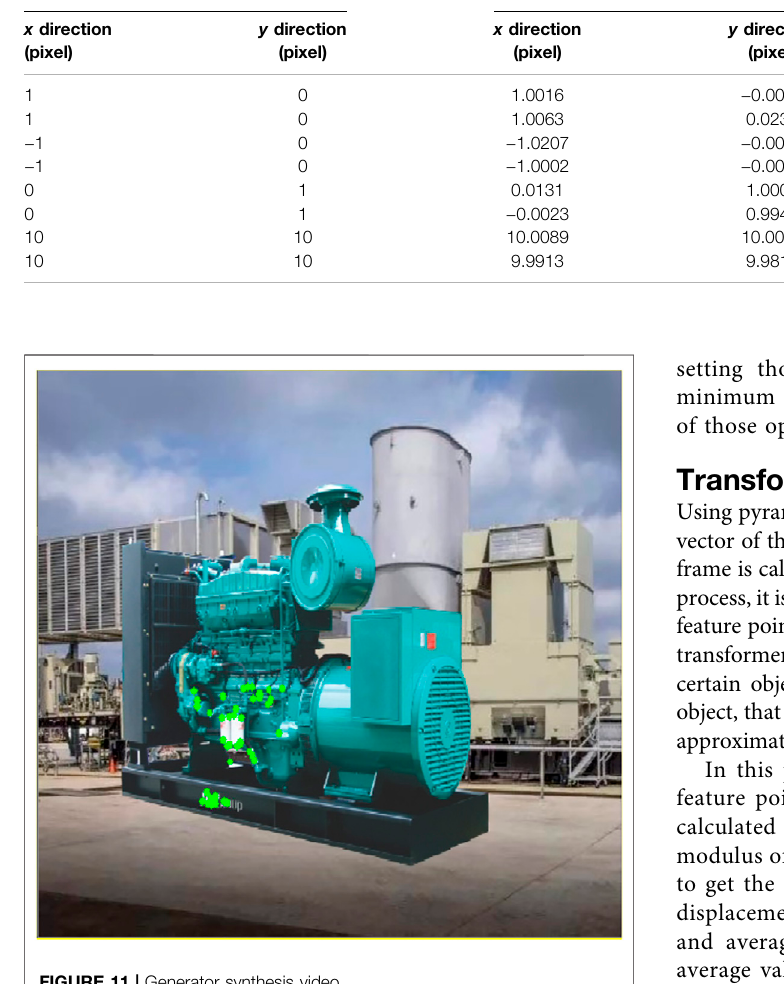
TABLE 1 | Comparison between the transformer vibration vectors calculated by the proposed algorithm and the vibration vectors which are assigned arti fi cially. Transformer vibration vectors which are assigned arti fi cially